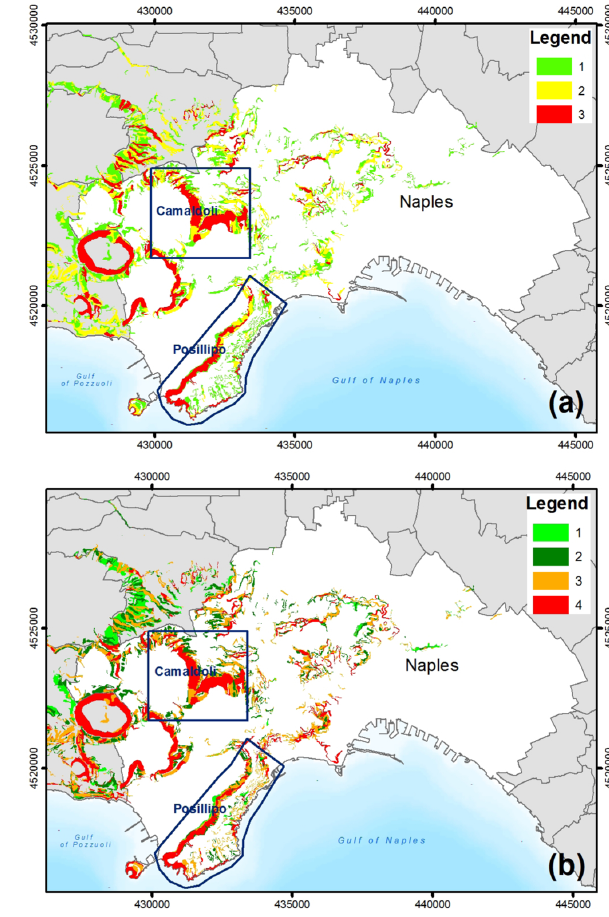
Fig. 15. Slope maps of Naples (above) and Ischia island (below).